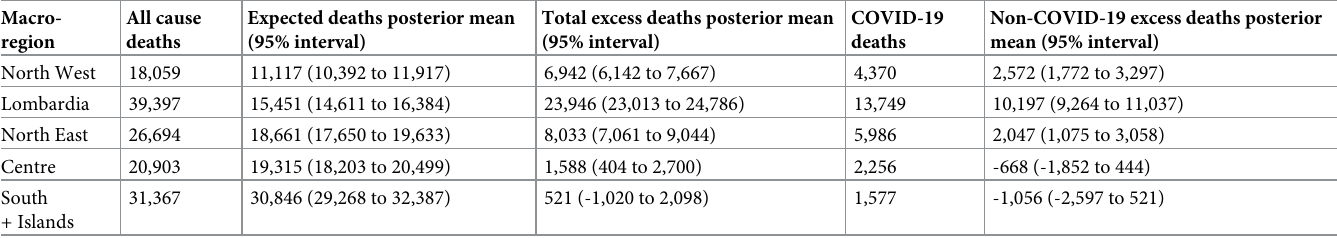
Table 1. Observed and modelled excess mortality by macro-regions and by direct COVID-19